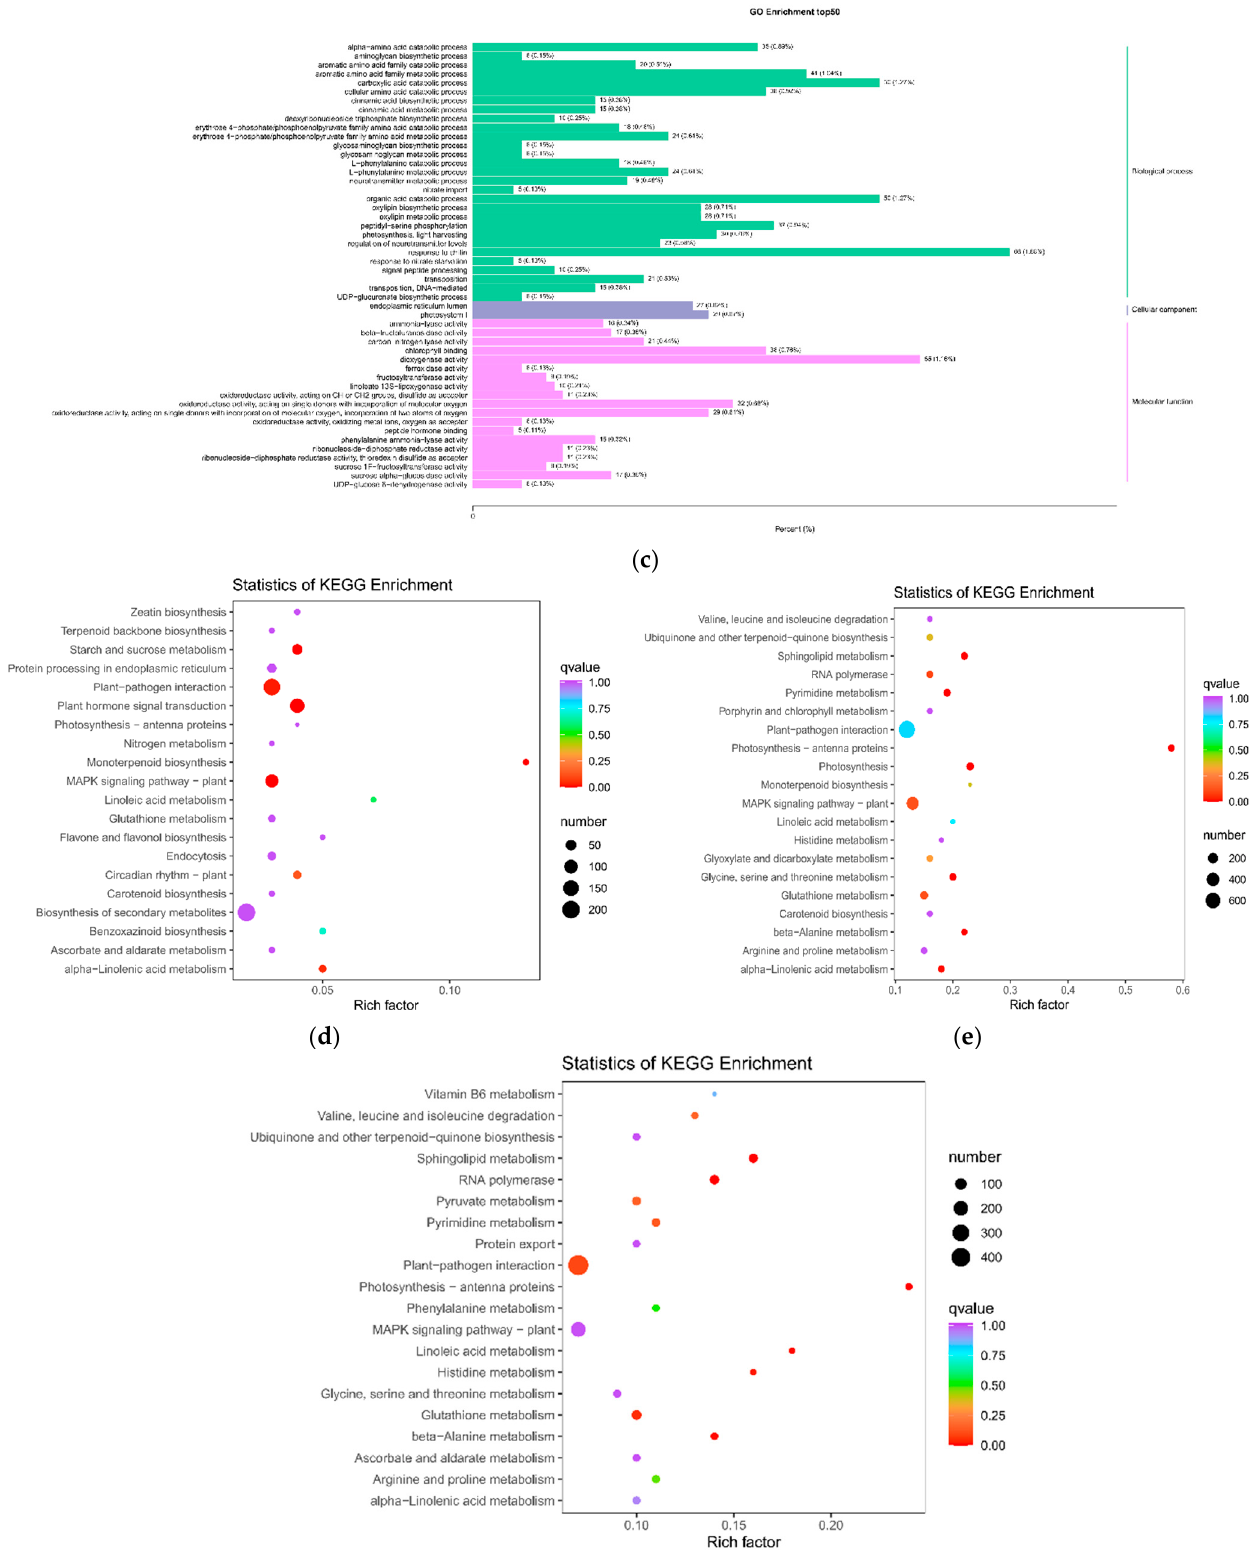
( f ) Figure 5. ( a ) L − K vs L − G. ( b ) N − G vs L − G. ( c ) N − K vs L − K. ( d ) L − K vs L − G. ( e ) N − G vs L − G. ( f ) N − K Figure 5. ( a ) L-K vs. L-G. ( b ) N-G vs. L-G. ( c ) N-K vs. L-K. ( d ) L-K vs. L-G. ( e ) N-G vs. L-G. ( f ) N-K vs. L-K. vs L − K. Histogram of GO enrichment entries ( a , b , c ) and KEGG enrichment scatter diagram ( d , e , f ). Histogram of GO enrichment entries ( a – c ) and KEGG enrichment scatter diagram ( d – f